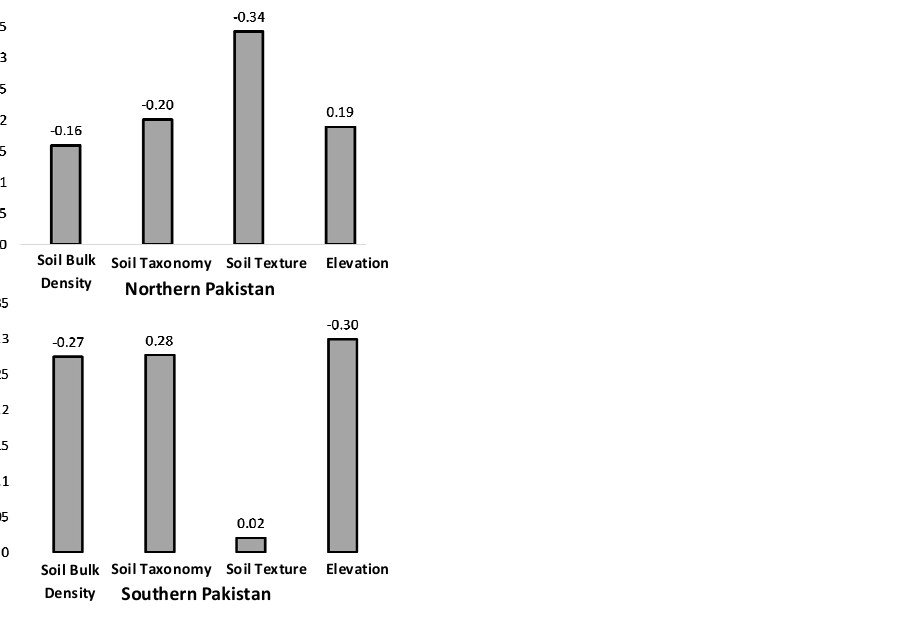
Figure 8. Pearson’s Temporal in Northern Pakistan ( top panel) and Southern Pakistan ( bottom panel), R of monthly FC in logarithm versus mean soil properties, elevation. R was calculated at monthly scales using data from 2001 to 2020.